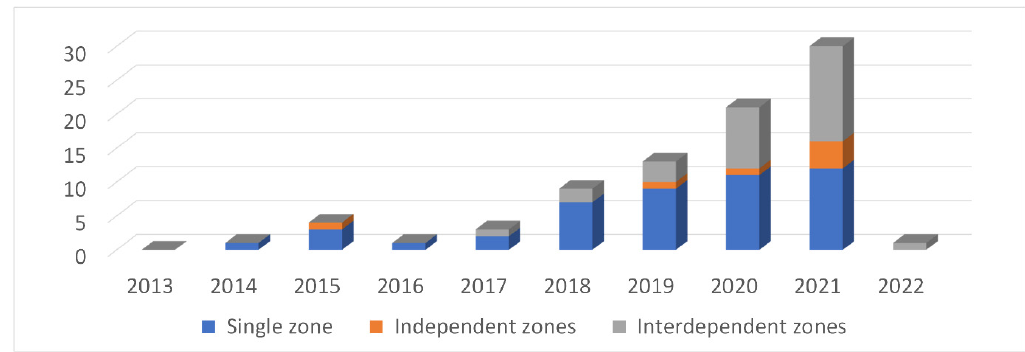
Figure 3. Number of articles in Tier 1 categories.